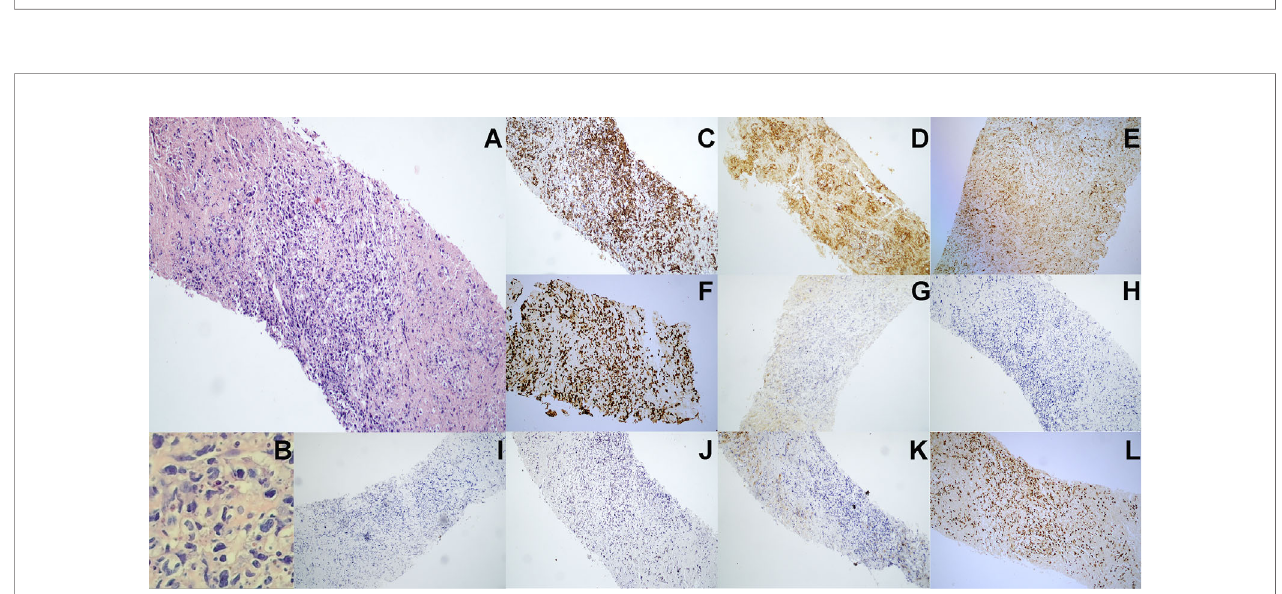
FIGURE 2 | Pathological immunohistochemistry of abdominal lymph node puncture. (A) H&E staining revealed the abnormal cell proliferation with lamellar necrosis in the abdominal lymph node biopsy tissue (100× manifestation). (B) H&E staining revealed the abnormal cells with large cell volume, abundant cytoplasm, irregular nuclei, thick nuclear chromatin and few visible nucleoli (200× manifestation). (C – J) Immunohistochemical staining showed that lymphoma cells were positive for (C) CD3, (D) CD8, (E) TIA-1 and (F) Ki-67 (approximately 90%), but were negative for (G) CD56, (H) CD4, (I) CD5, (J) CD30 and (K) CD20. (L) EBV-encoded RNA (EBER) in situ hybridization revealed the positive EBV